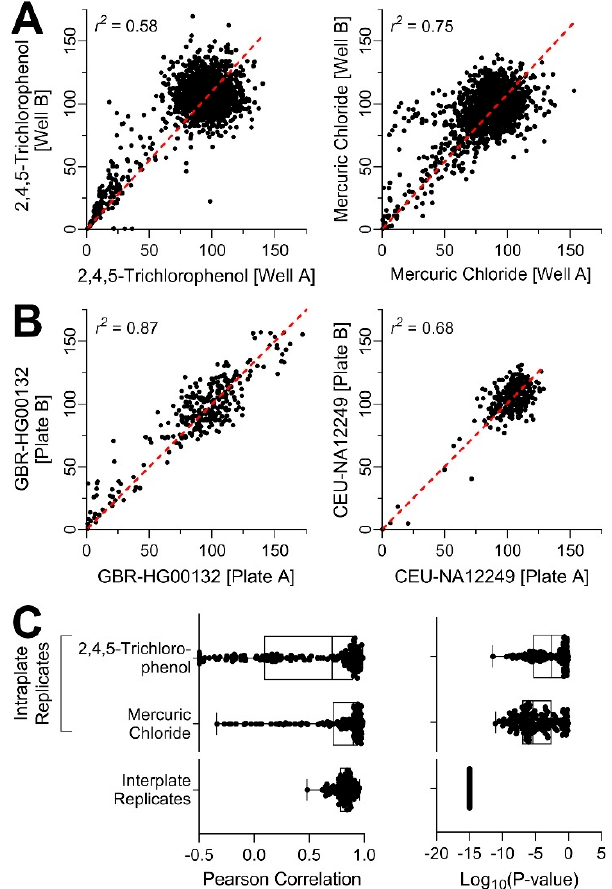
Figure 3. Technical reproducibility of in vitro cell viability assays across all donors. ( A ) Intra-plate reproducibility correlation plots of the two intra-plate replicate substances: 2,4,5-trichlorophenol and mercuric chloride, correlations include the entire concentration–response profile for all cell lines tested. ( B ) Inter-plate reproducibility correlation plots. Of the three plate replicates available, two were randomly selected for correlation analysis. Representative plots are shown for the most susceptible cell line GBR-HG00132 (i.e., highest variability across all chemical-specific PODs, left) and the most resistant cell line CEU-NA12249 (i.e., lowest variability across all PODs, right). ( C ) Distribution of Pearson correlation coefficients and the corresponding p -values for intra- and inter-plate replicates across all cell lines.